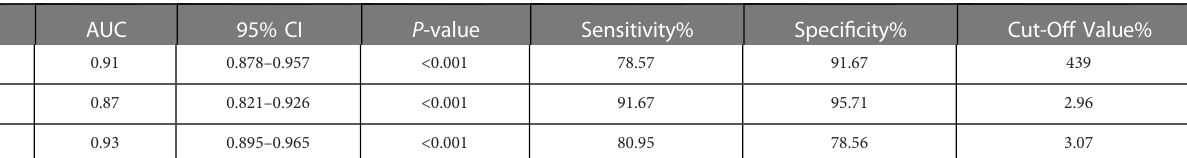
TABLE 4 Sensitivity, speci fi city and cut-off value of serum BNP and TnI and DFR levels.